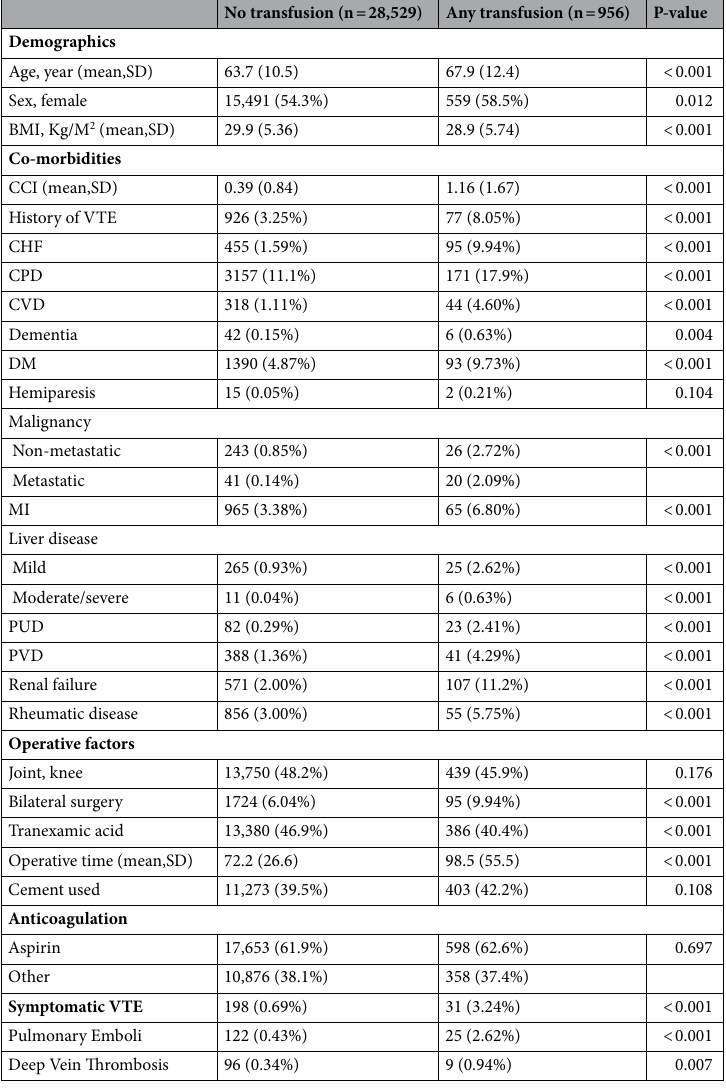
Table 1. Patient characteristics, comorbidities, operative factors and type of VTE prophylaxis for the primary TJA cohort and their VTE rates. BMI Body Mass Index, Kg kilogram, M meter, CCI Charlson Comorbidity Index, CHF congestive heart failure, CPD cardiopulmonary disease, CVD cardiovascular disease, DM diabetes mellitus, MI myocardial infraction, PUD peptic ulcer disease, PVD peripheral vascular disease, VTE